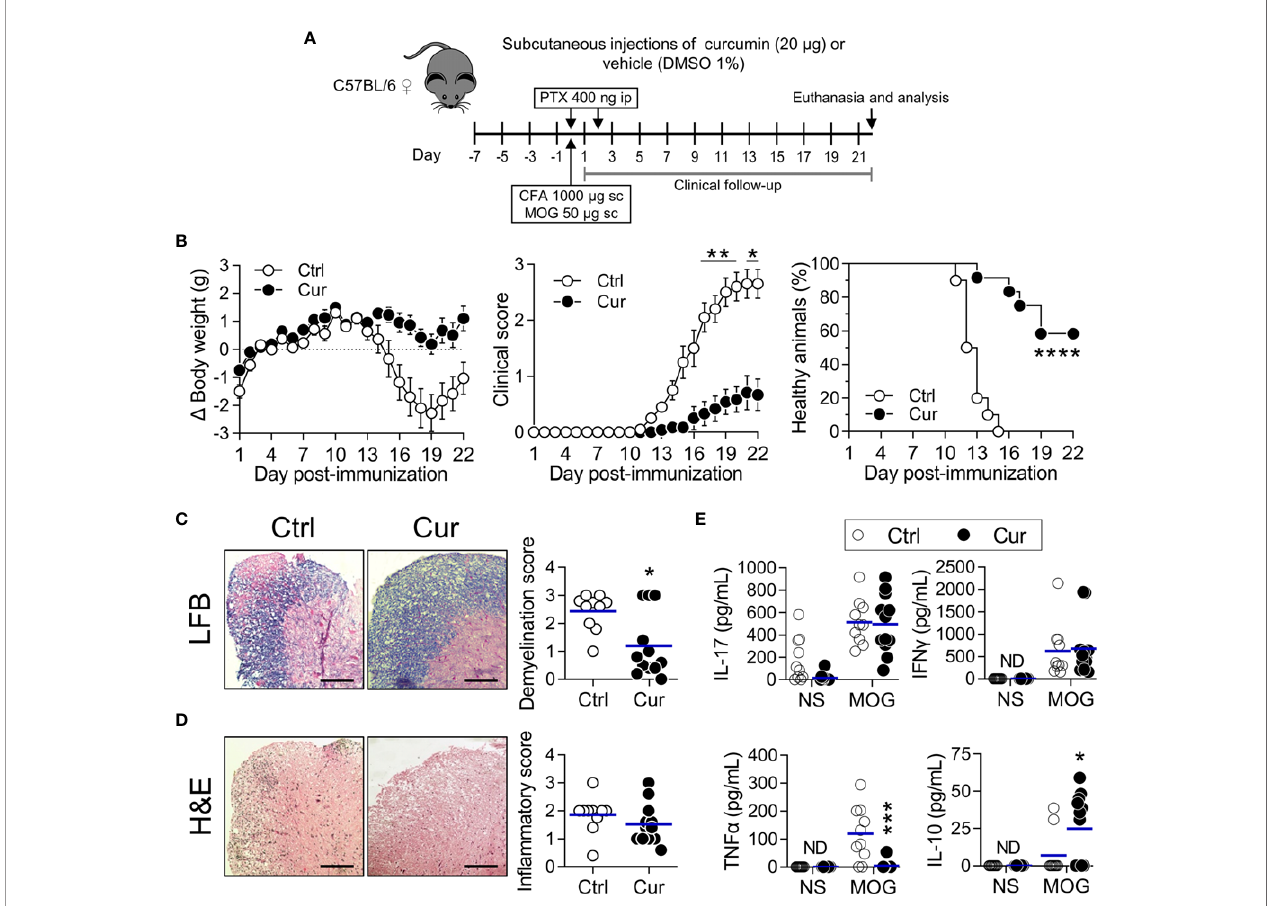
FIGURE 4 | Subcutaneous microdose curcumin is also neuroprotective. (A) WT C57BL/6 female mice were treated subcutaneously in the hind footpads every other day with curcumin (Cur, 10 µg each footpad, 20 µg per mouse, approximately 0.8 mg/kg) or vehicle (DMSO 1%; Ctrl), 7 days prior EAE induction (day 0) and until the end of the experiment, as shown. Clinical follow-up was performed daily, and after euthanasia (day 22), samples were collected to perform histopathological analysis and immunological tests. (B) Changes in body weight (left), clinical score (center) and percentage of healthy animals (right) were recorded daily after immunization (see Materials and Methods for details). Data is presented as the mean ± SEM (left and center). Percentage of healthy animals (right) was plotted as a Kaplan-Meier curve. (C, D) Representative images of the lumbar cord sections stained with (C) LFB and (D) H&E. Plotted data represents the (C) demyelination score and (D) in fl ammatory score obtained after image analysis from each animal in both treatment groups. Scale bar=25 µm. Each point represents individual animals and bars represent the mean of the group. (E) 2.0×10 6 /mL splenocytes were stimulated with MOG (20 µg/mL) or PBS (NS) for 72 h. The amounts of the indicated cytokine produced by cells in response to stimuli were quanti fi ed in supernatants by ELISA. ND, not detected. Results are plotted as individual animals and mean (n=10-12). *P < 0.05; **P < 0.01; ***P < 0.001; ****P < 0.0001. Statistical tests were: ( B , left and center) Two-way ANOVA for repeated measures with Bonferroni ’ s post-test, ( B , right) Mantel-Cox test and (C – E) Mann-Whitney U